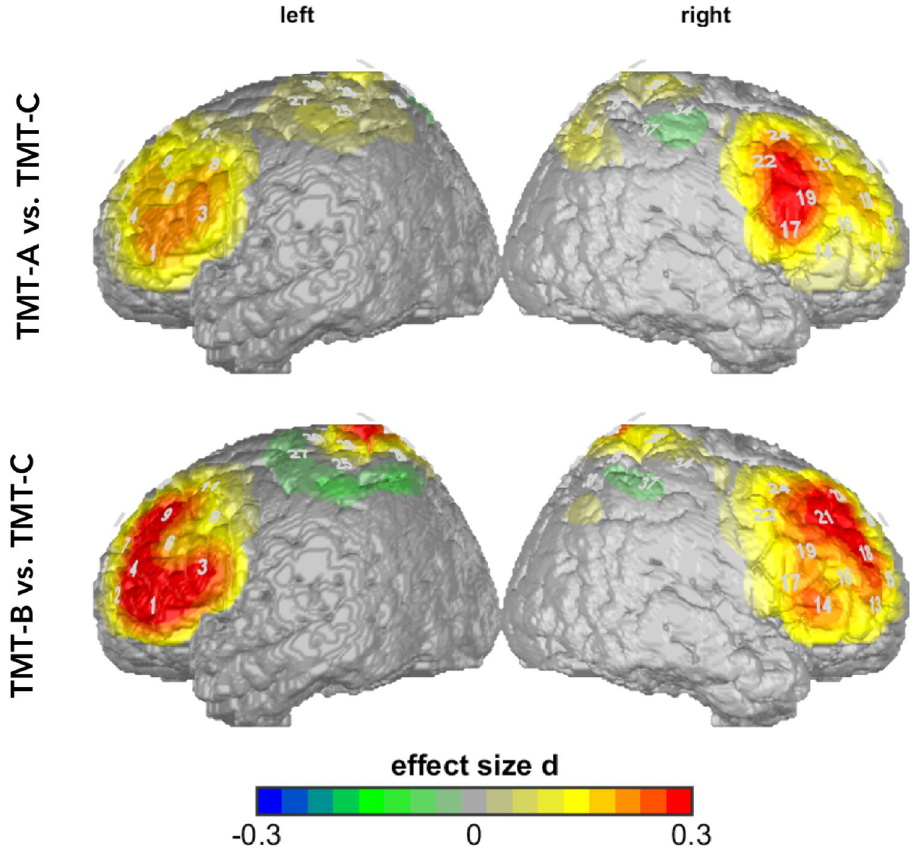
Figure 4. Item-corrected data (O 2 Hb/item): activity in TMT-A and TMT-B versus TMT-C. Differences are shown in effect size Cohen’s d.